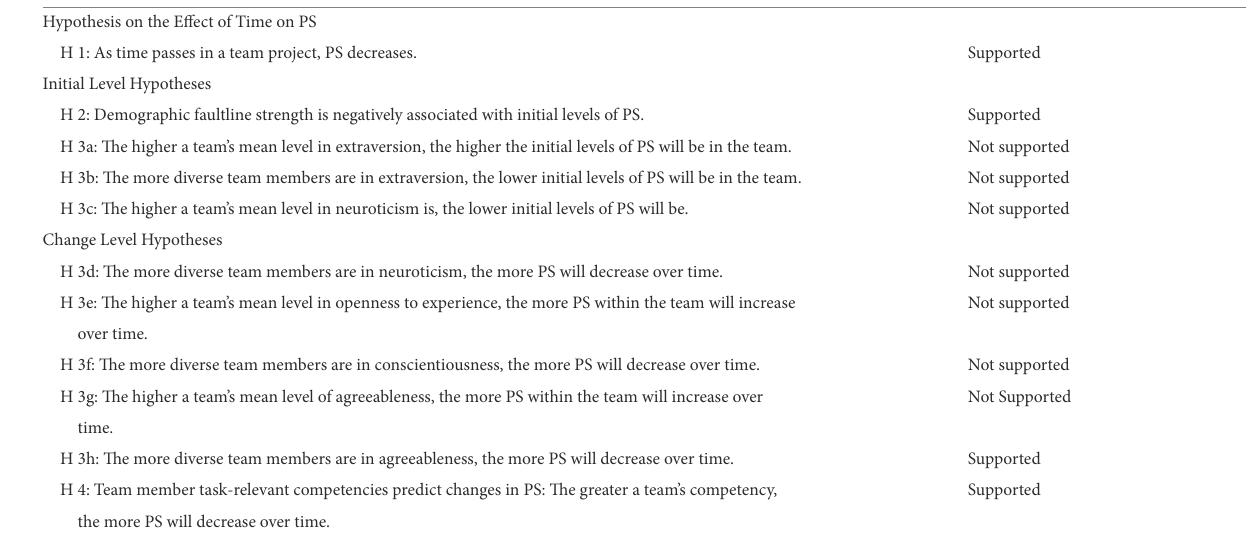
TABLE 7 Hypotheses and support for initial levels and changes in team psychological